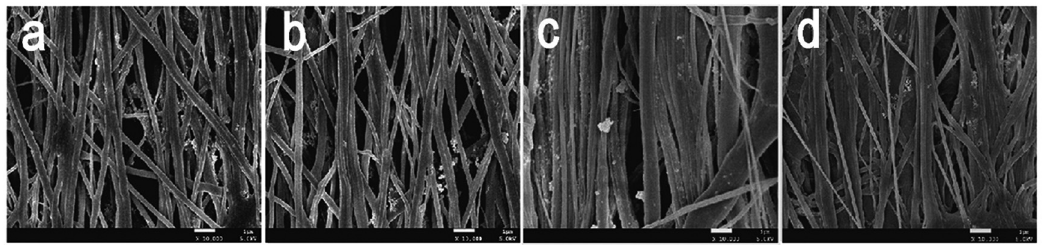
Figure 12: SEM images of CNF/CNC nanocomposite nano fi bres: ( a ) 0% CNC, ( b ) 5% CNC, ( c ) 12.5% CNC, and ( d ) 20% CNC. Adapted from ref. [ 68 ] .